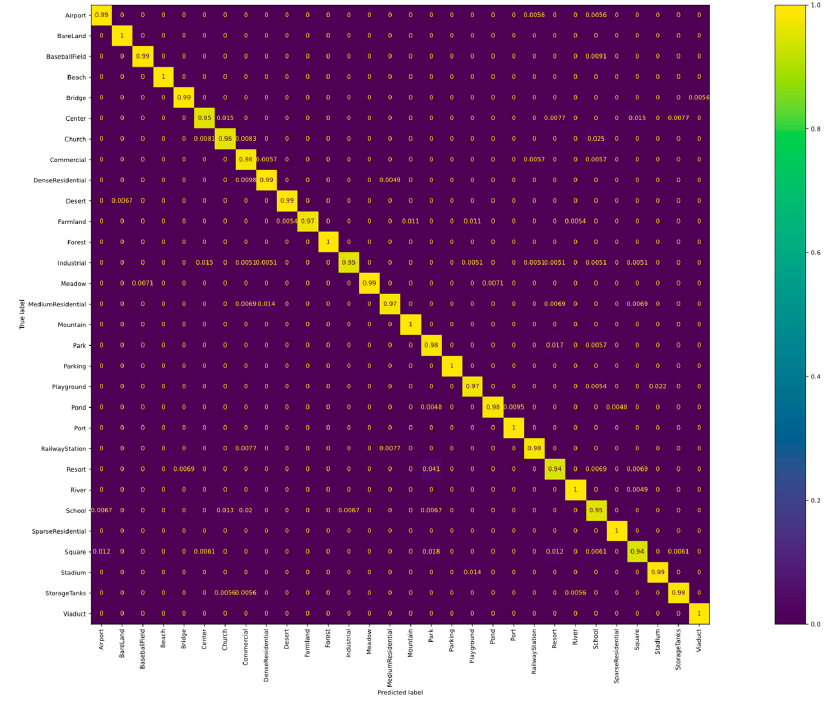
Figure 6. Confusion matrix of HCFPN for the AID dataset with 50% training data.